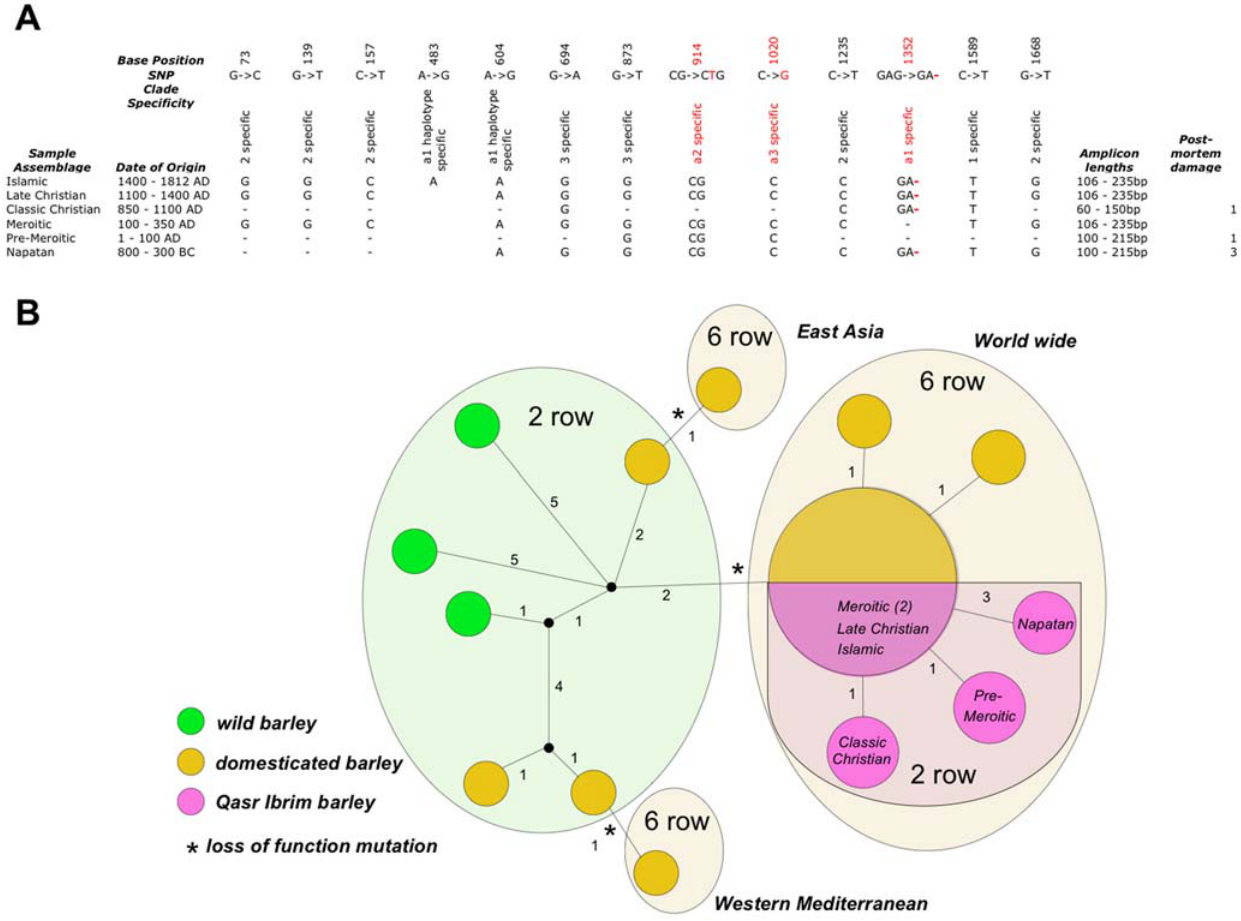
Figure 3. Characterisation of Vrs1 locus in Qasr Ibrim barley. (A) Analysis of Qasr Ibrim barley for haplotype specific polymorphisms [9]. SNPs coloured in red indicate vrs1 loss of function mutations.–indicates where sequencing data were not available. (B) Phylogenetic tree of Vrs1 alleles indicating the position of the Qasr Ibrim barley within the vrs1.a1 clade.